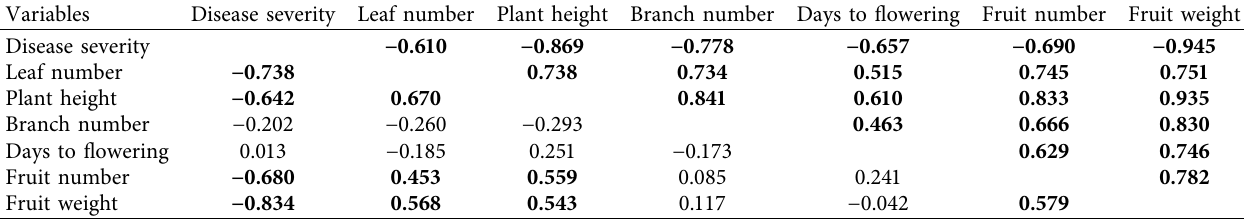
Table 9: Correlation between disease severity, growth, and yields of tomato